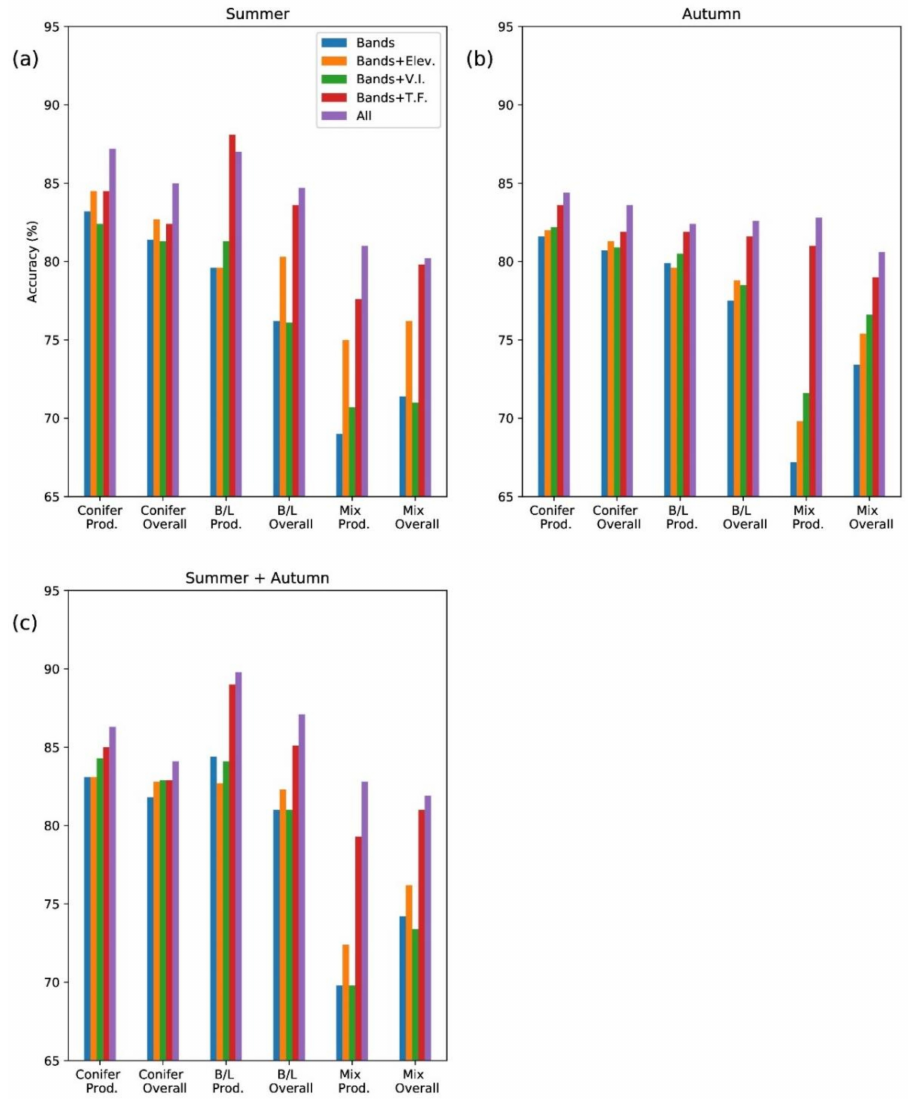
Figure 6. Old-Growth Forest (OGF) Producer’s and overall accuracies resulting from Random Forest classification for OGF and Non-OGF polygons for 5 selected models for ( a ) summer (2 August 2017) ( b ) autumn (16 October 2017) and ( c ) summer +